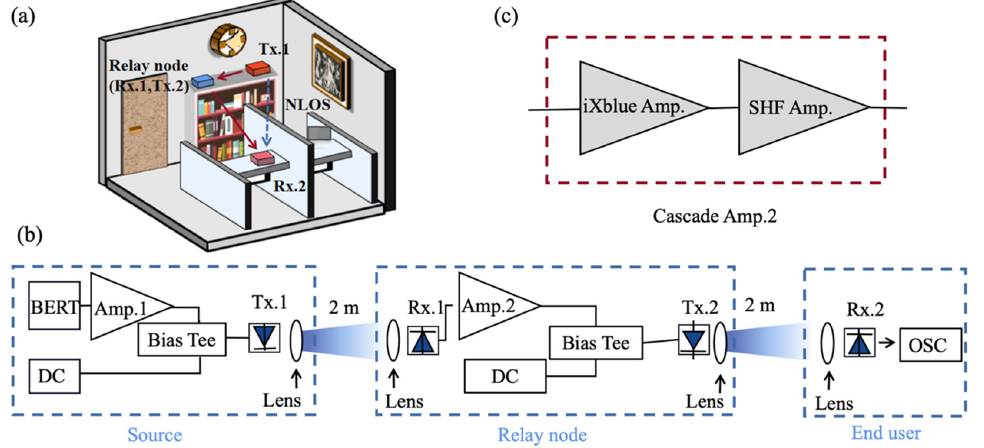
Figure 1. ( a ) Schematic diagram of dual-hop VLC-link setup. ( b ) Diagram of dual-hop VLC-link setup. ( c ) The cascade structure of Amp.2 with detailed order and type. (Tx.: Transmitter; Rx.: Receiver; Amp.: Amplifier; BERT: Bit-error-rate tester; DC: Direct current).